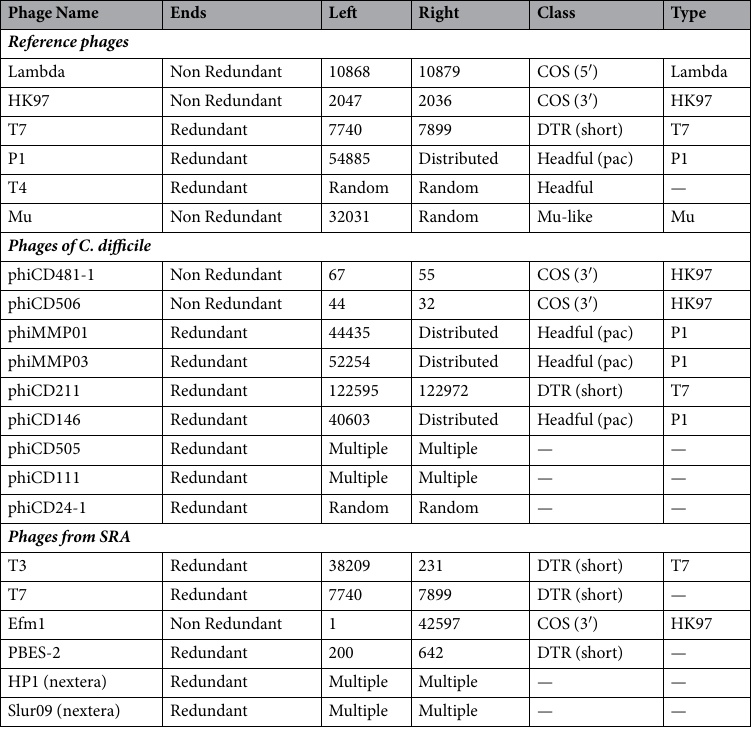
Table 2. Summary of PhageTerm